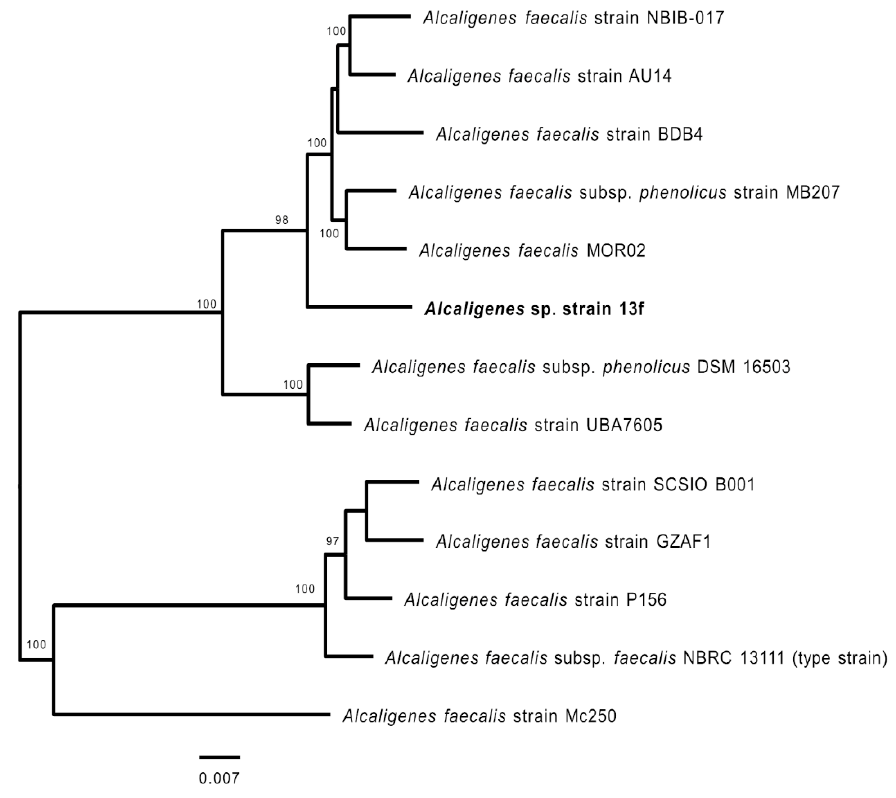
Figure 2. Phylogenomic analysis of Alcaligenes spp. including Alcaligenes sp. strain 13f (bold font). The tree shown is a maximum likelihood phylogeny of 500 genes (presented in Table S1), based on 100 rounds of rapid bootstrapping. Only the bootstraps supporting values of >50% are shown.